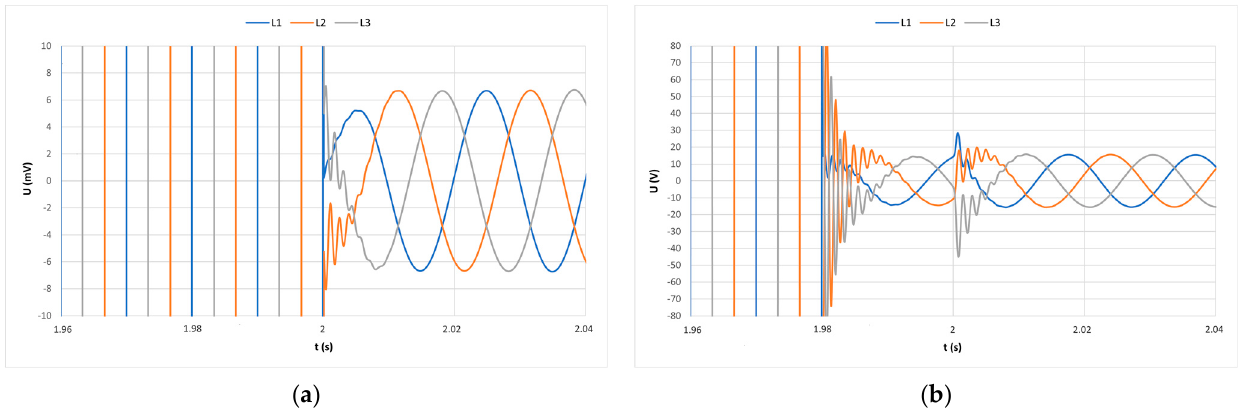
Figure 15. Simulated values of PV station model voltages during a 3-Ph ground fault condition at: ( a ) the source; ( b ) the end of transmission line.